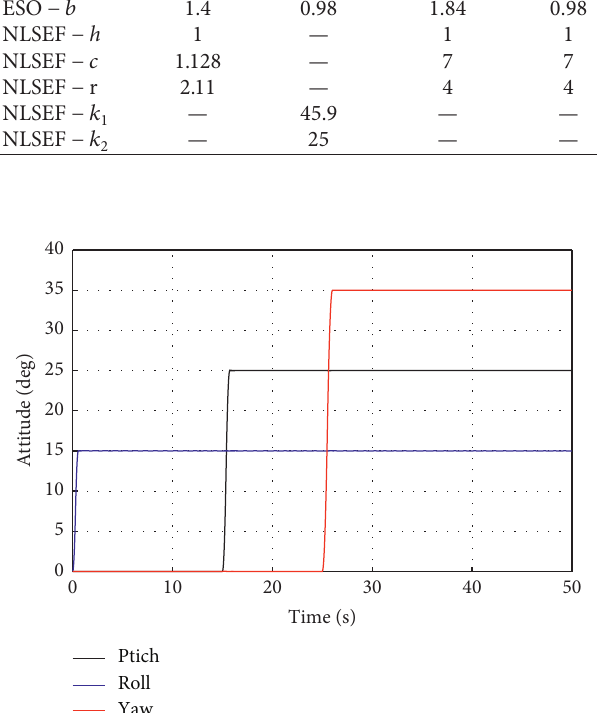
Figure 3: Curve of attitude